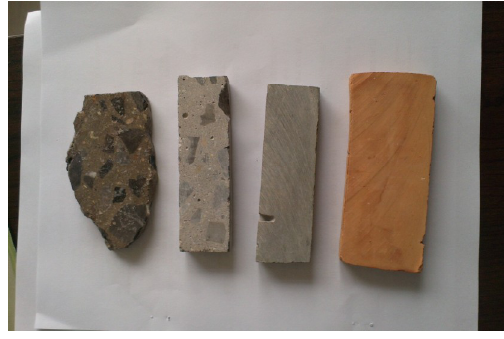
Figure 2. Aggregate test piece.